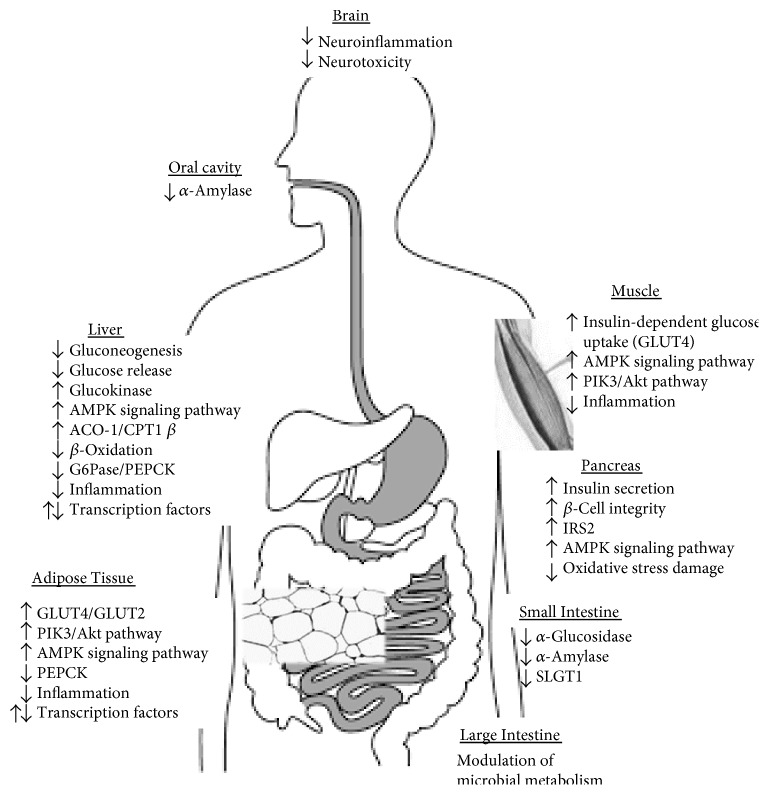
Relevant mechanisms linking dietary polyphenols and T2D risk. Polyphenols can exert a beneficial effect on type 2 diabetes by a number of mechanisms including (a) slowing carbohydrate digestion and glucose absorption by interacting with oral cavity and intestinal α-amylase and intestinal α-glucosidase and sodium-dependent glucose transporter (SLGT1); (b) stimulating insulin secretion in the pancreas via increasing 5′ adenosine monophosphate-activated protein kinase (AMPK) pathway, and insulin receptor substrate (ISRS) and decreasing β-cell oxidative damage which preserves β-cell integrity; (c) modulating liver glucose release due to increase in acyl-CoA oxidase 1 (ACO-1) and carnitine palmitoyl transferase 1-β (CPT1-β) and diminishing glucose 6 phosphatase (G6Pase) and phosphoenolpyruvate carboxylase (PEPCK); and (d) activation of glucose uptake receptors in the insulin-sensitive tissue. Additionally, the modulation of microbial metabolism can synergically benefit glucose homeostasis.